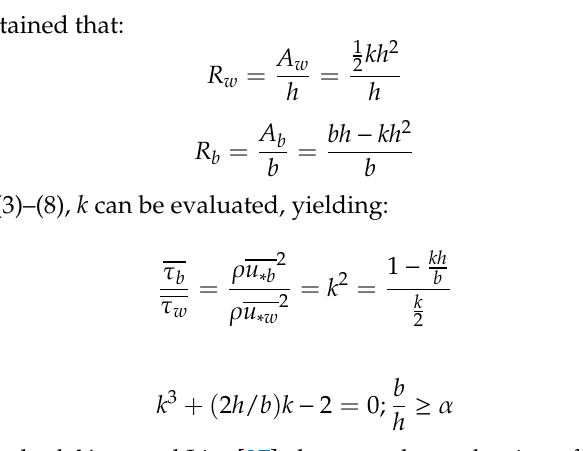
Figure 1. Division lines for smooth rectangular channels: ( a ) b/h≥α ; ( b ) b/h≤α .